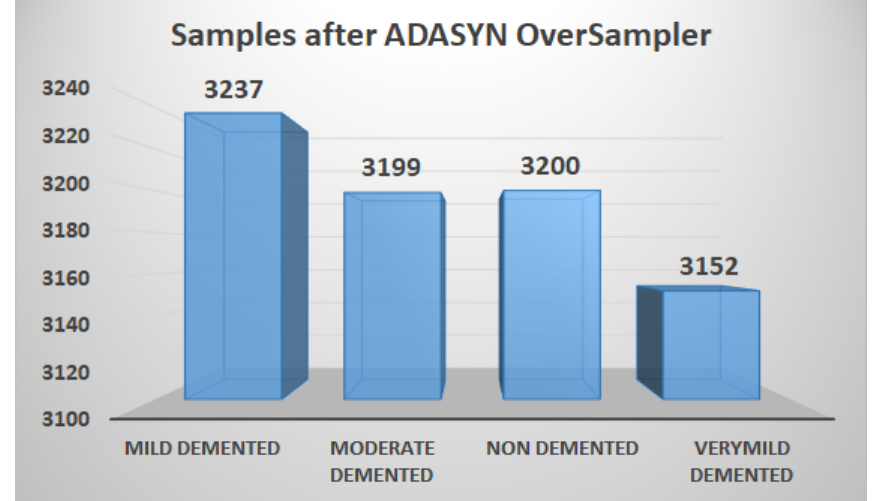
Figure 5. AD data-set class distribution after up-sampling through ADASYN.